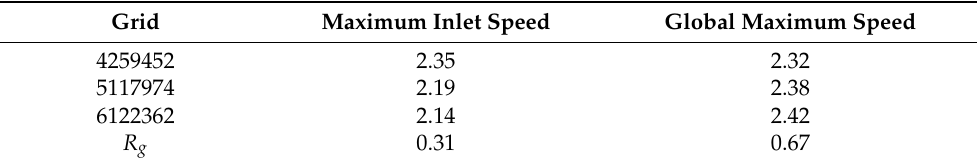
Table 2. Verification of grid independence.